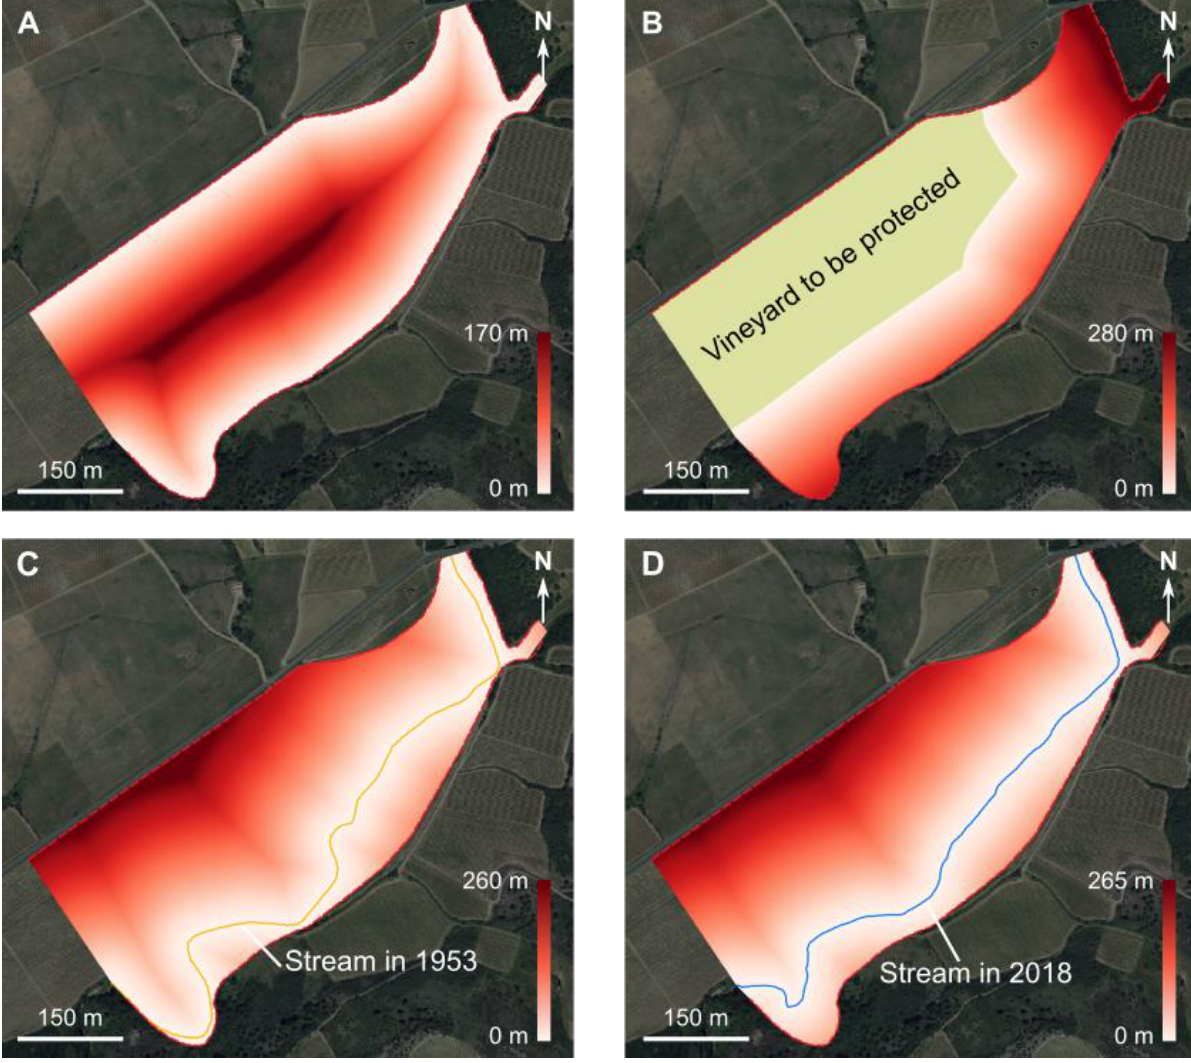
Figure 9. Raster proximity maps used for the calculation of the indicators along the Clamoux River. Raster proximity map of the floodplain margins ( A ); raster proximity map of the edges of the vineyard ( B ); raster proximity map of the 1953 active channel ( C ); raster proximity map of the 2018 active channel ( D ).